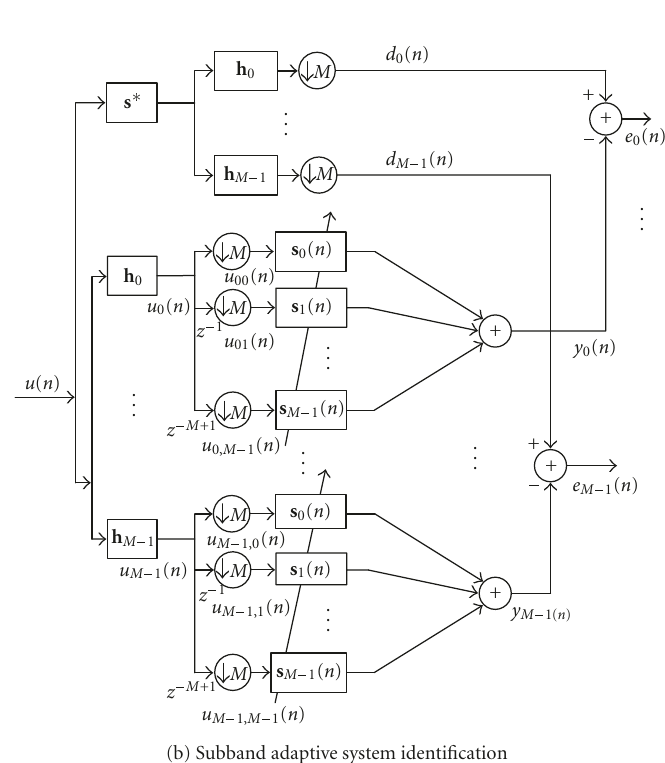
Figure 2: Subband system identification for adaptive acoustic echo